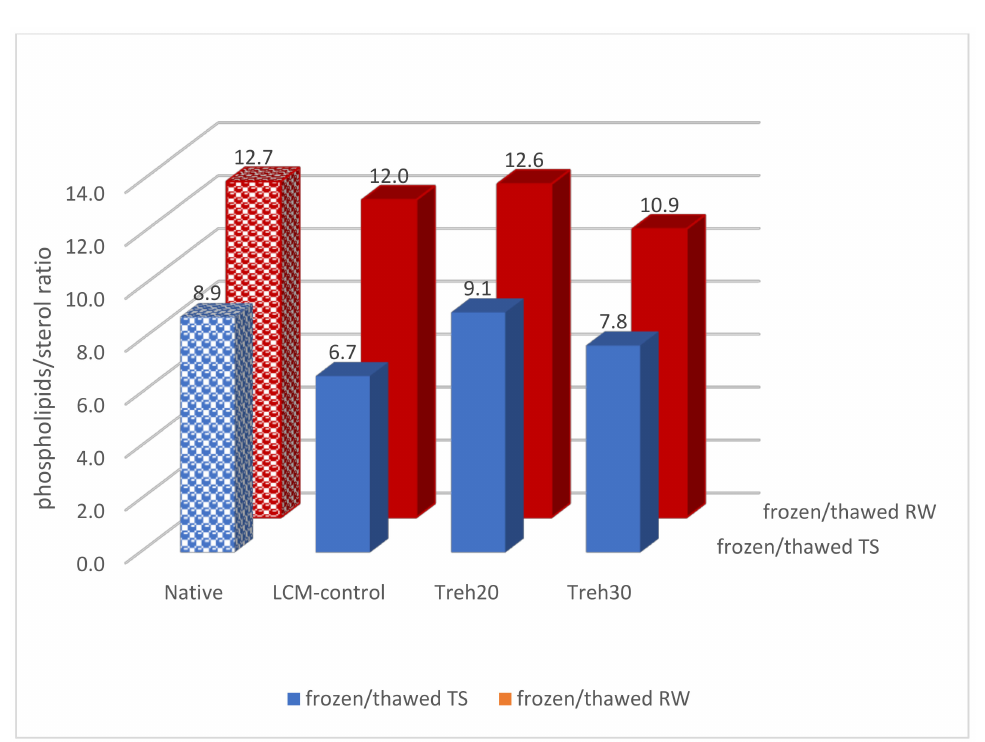
Figure 2. The ratio of the total fraction of phospholipids to the content of sterol in the membranes of spermatozoa of native and frozen/thawed rooster semen depending on the breed and composition of the cryoprotective